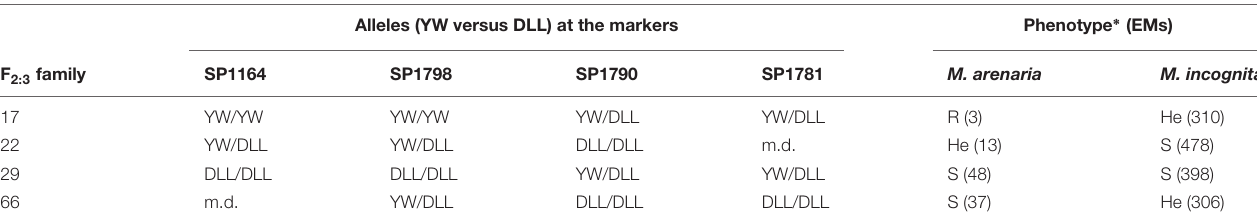
TABLE 3 | Recombinant genotypes within the cluster of QTLs on chromosome P1 containing Minc-P1 and Mare-P1 . Alleles (YW versus DLL) at the